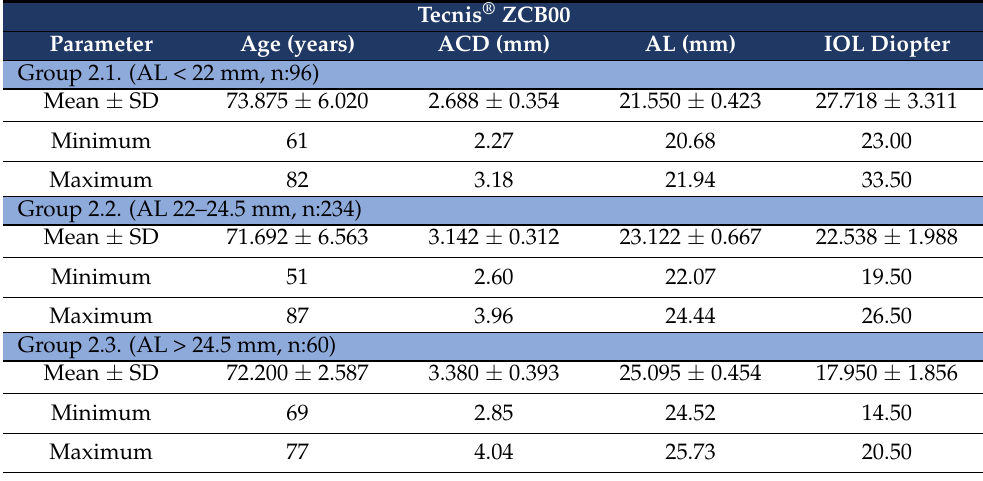
Table 4. Descriptive data of each group with Tecnis ® ZCB00